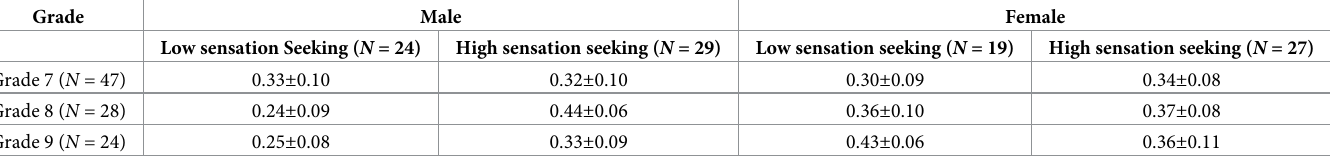
Table 2. Mean and standard deviation of the duration of first fixation for adolescents crossing road ( s ). Grade Male Female Low sensation Seeking ( N = 24) High sensation seeking ( N = 29) Low sensation seeking ( N = 19) High sensation seeking ( N = 27) Grade 7 ( N = 47) 0.33 ± 0.10 0.32 ± 0.10 0.30 ± 0.09 0.34 ± 0.08 Grade 8 ( N = 28) 0.24 ± 0.09 0.44 ± 0.06 0.36 ± 0.10 0.37 ± 0.08 Grade 9 ( N = 24) 0.25 ± 0.08 0.33 ± 0.09